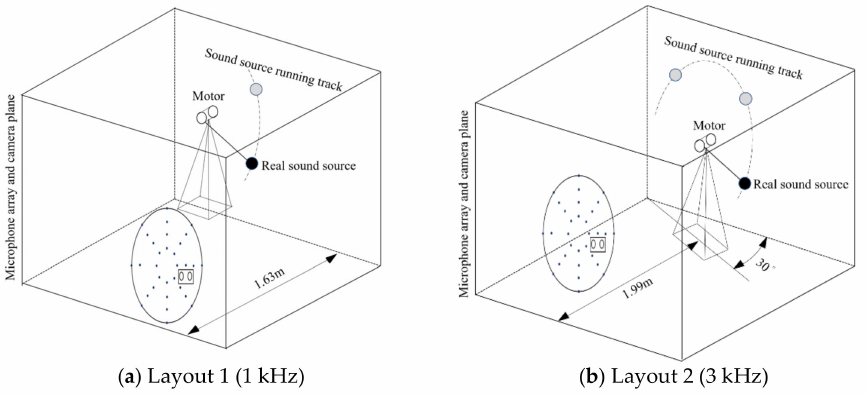
Figure 5. Geometry schematic of the experiment.